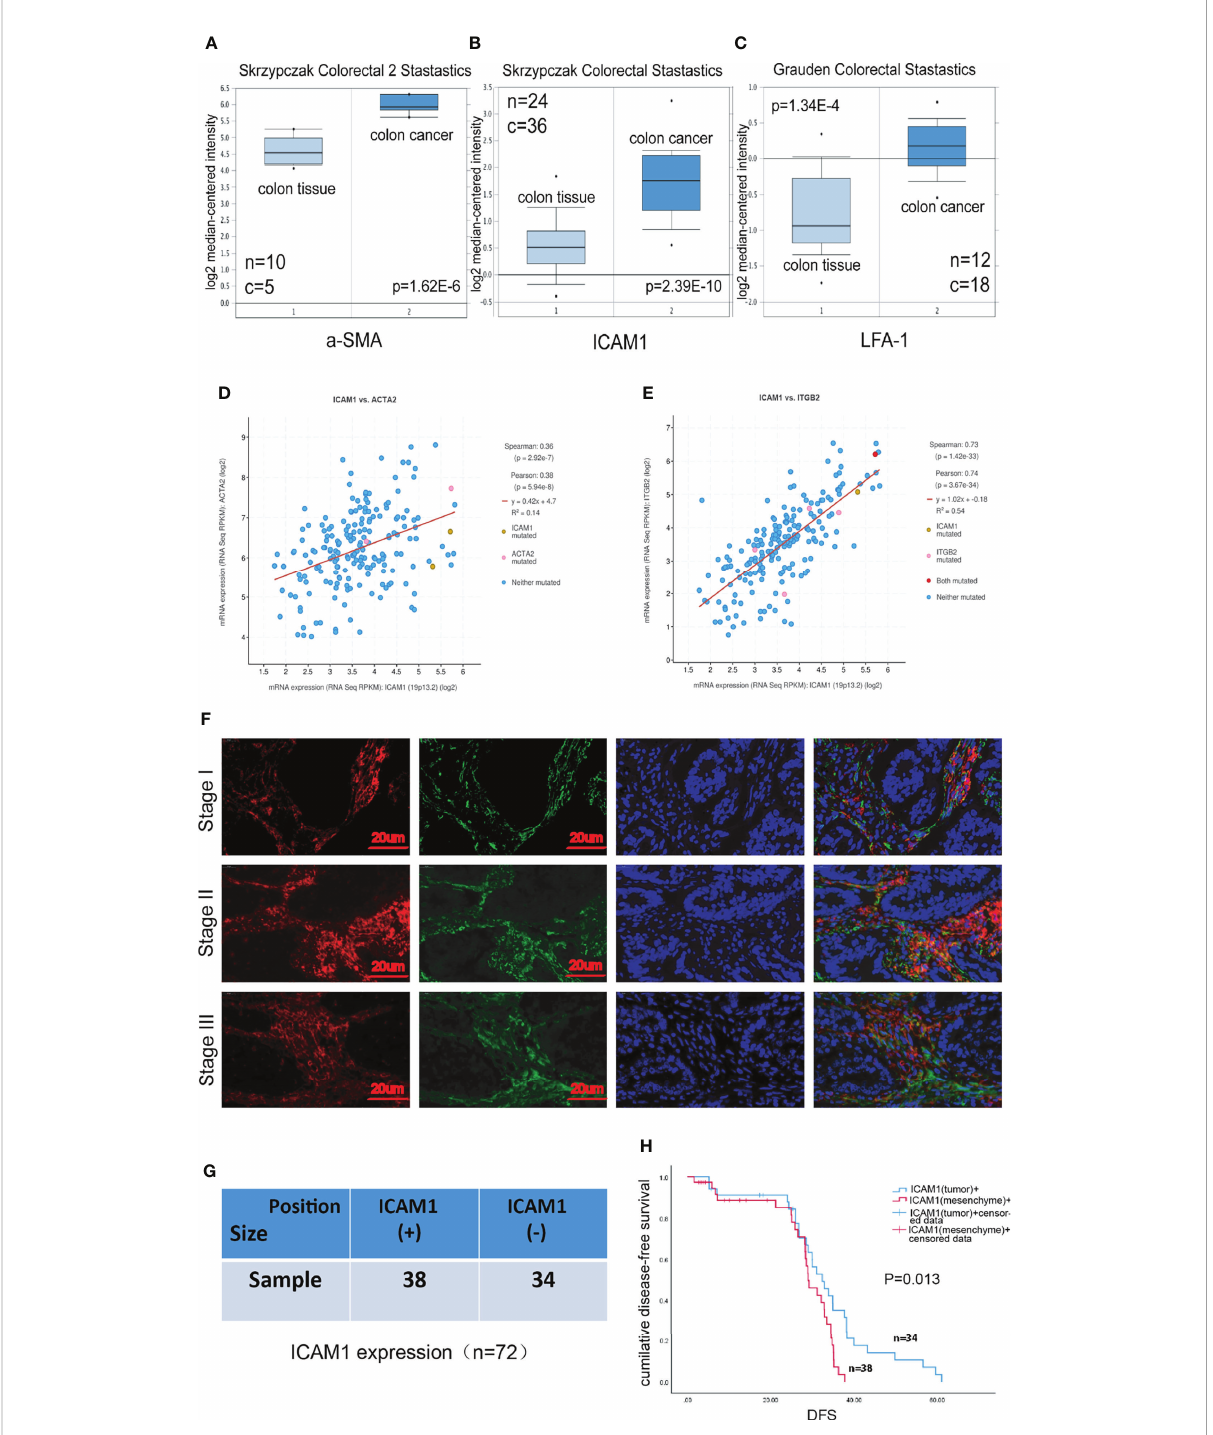
FIGURE 2 ICAM-1 expression has a poor prognosis in patients. (A – C) The expression analysis in relation to ICAM-1, a -SMA, and LFA-1 from Oncomine Database, respectively. (D, E) cBioPortal Database indicated the correlation between ICAM-1 and a -SMA or LFA-1. (F) Colon cancer tissues specimens consisting of patients with stage I, II, and III CRC were immuno fl uorescent staining with antibody against ICAM-1 (red), a -SMA (green), and nucleus (blue). (G) The enrolled 72 patients were divided into two groups including only mesenchymal ICAM-1 positive (30) and mesenchymal ICAM1 negative (31). (H) Kaplan – Meier curves for DFS of mesenchymal ICAM-1 expression. *p<0.05, **p<0.01, and